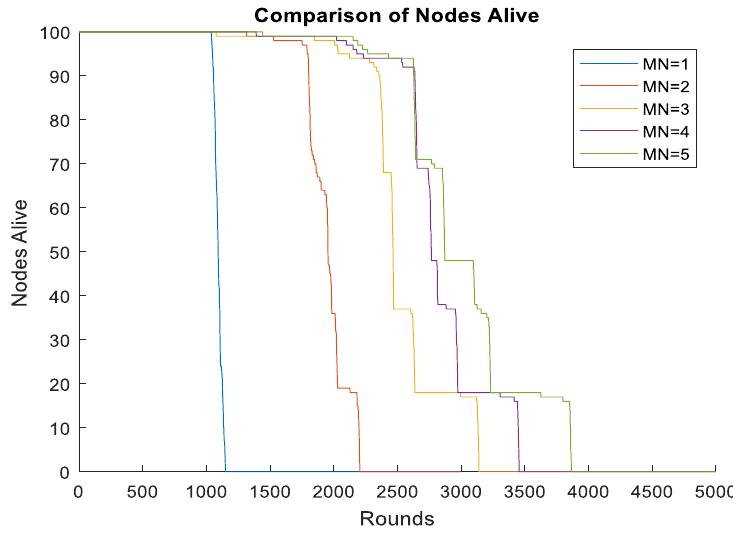
Figure 15. Different mobile sink number.